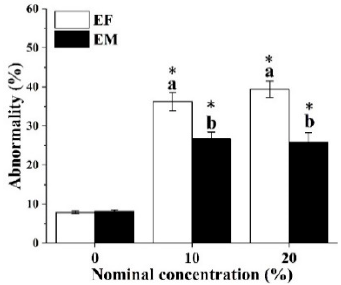
Figure 5. Morphological abnormalities of 48 hpf larvae derived from different parental exposed be- haviors with HFO WAFs. Data were presented as means ± SD. Lowercase letters indicate significant differences between sexes. An asterisk (*) labeled above bars indicates significant differences between different treatments and the control ( p < 0.05).